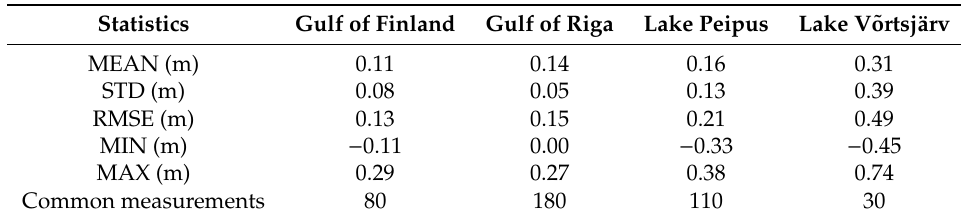
Table 4. Statistics of di ff erences between the sea surface height ( ∆ SSH GNSS ) derived from GNSS measurements ( SSH GNSS ) and sea surface height derived from altimetry ( SSH SA ) according to the Equation (6).